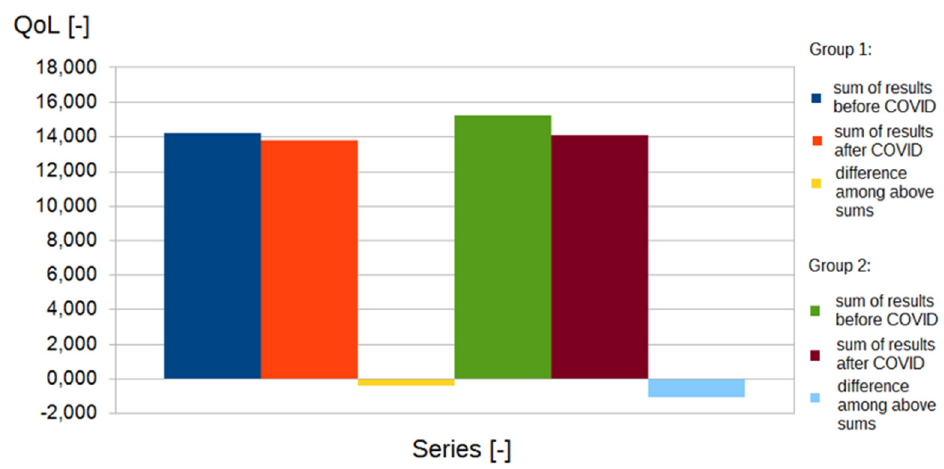
Figure 4. Comparison of fuzzy Quality of Life between group 1 and group 2. Table 9. Verification of models: correlations between their results and change intest